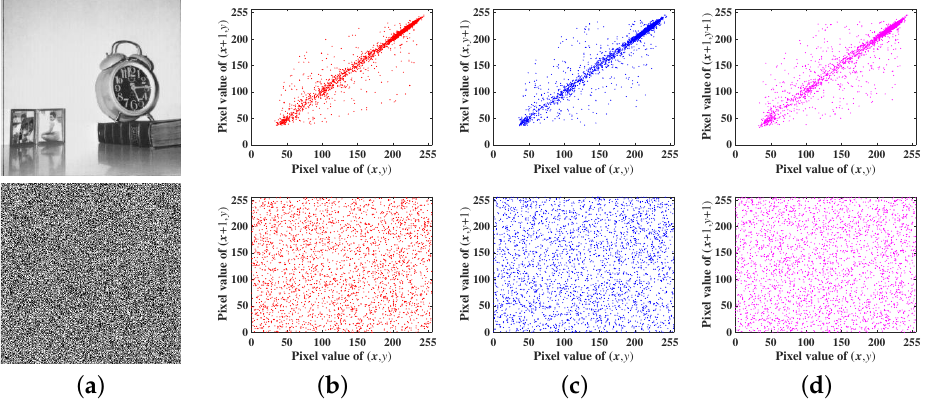
Figure 12. Correlation between adjacent pixels in plain and cipher images: ( a ) 5.1.12 and its cipher image; ( b ) horizontal direction; ( c ) vertical direction; ( d ) diagonal direction. Table 5. CCs of different plain and cipher